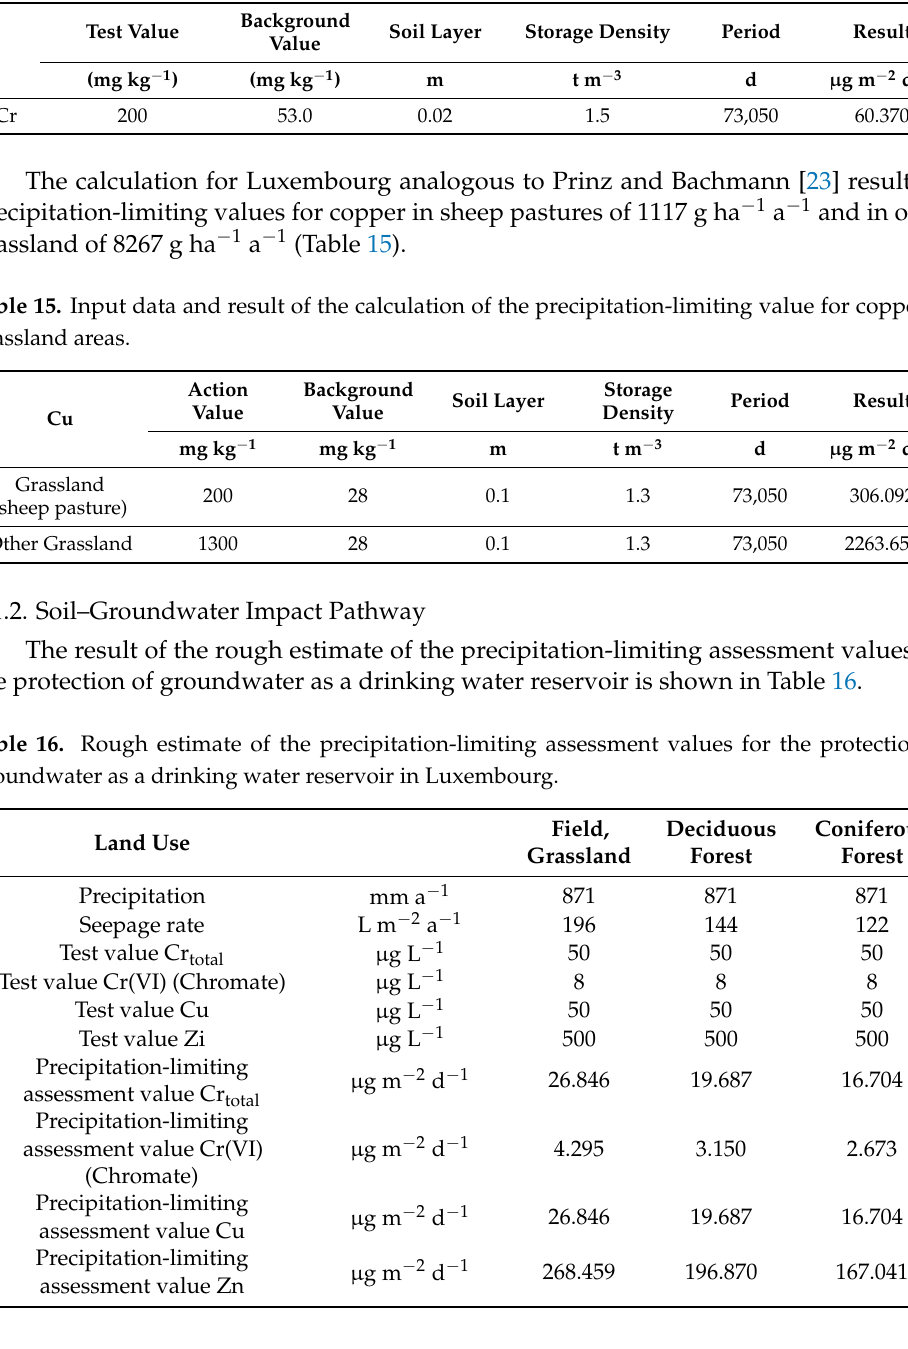
Table 14. Input data and result of the calculation of the precipitation-limiting value for chromium in settlement areas.